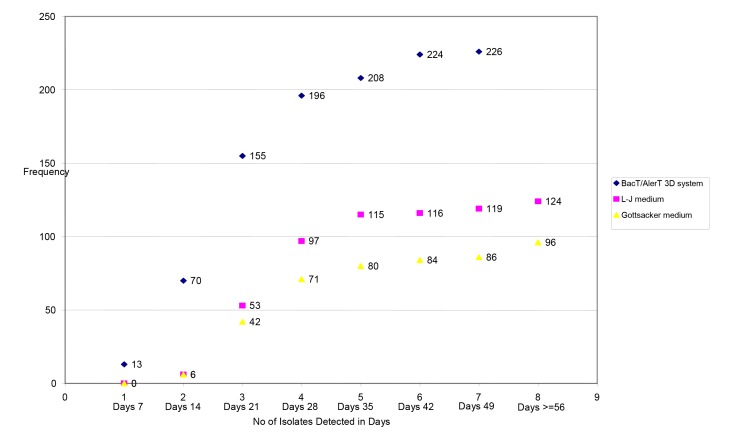
Dot line graph that shows the number of isolates using different culture media at different periods of time, northern Ethiopia.